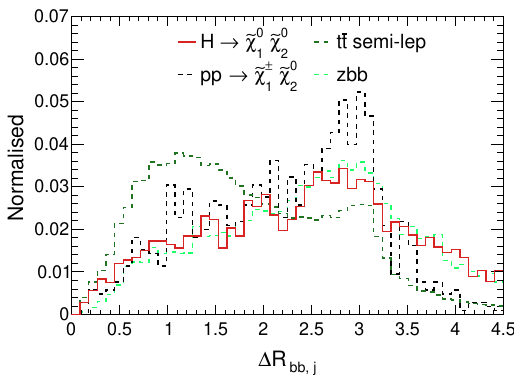
Figure 19. The normalised distributions of ∆ R bb,j for the t ¯ t semi-leptonic background along with other dominant backgrounds in the b-tag category of b ¯ b + /E Overlaid in solid is the distribution for the 5 F scheme signal process.